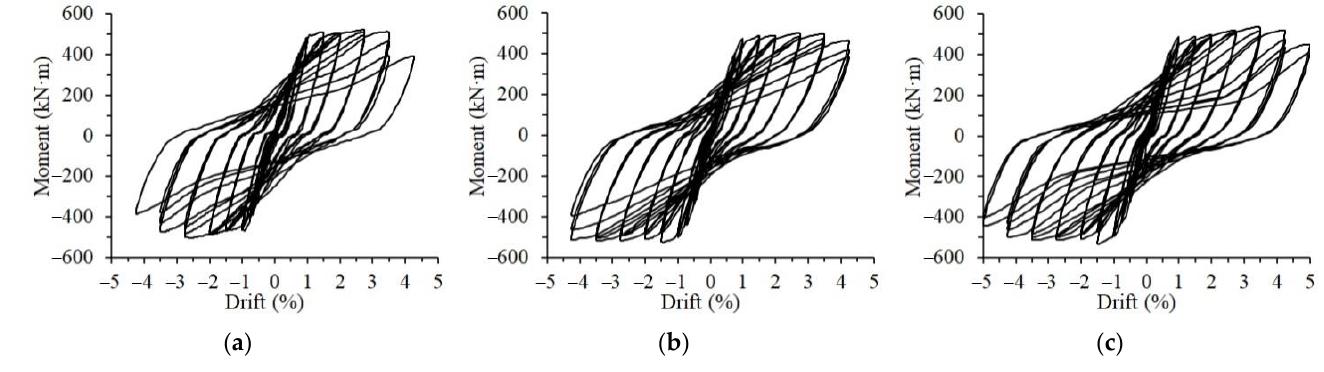
Figure 7. Hysteresis curves of the test specimens. ( a ) S1, ( b ) PU1, ( c ) PU2. By picking up the peak points in the hysteresis curves at different loading amplitudes, the actual skeleton curves were obtained, as shown in Figure 8a. The precast specimens were manufactured from the concrete and the reinforcing rebars of the same grade as the monolithic reference specimens at different times. To reduce the influence of the minor difference between the strength of the employed materials at different times, the positive and negative applied loads of the three specimens were normalized, being divided by